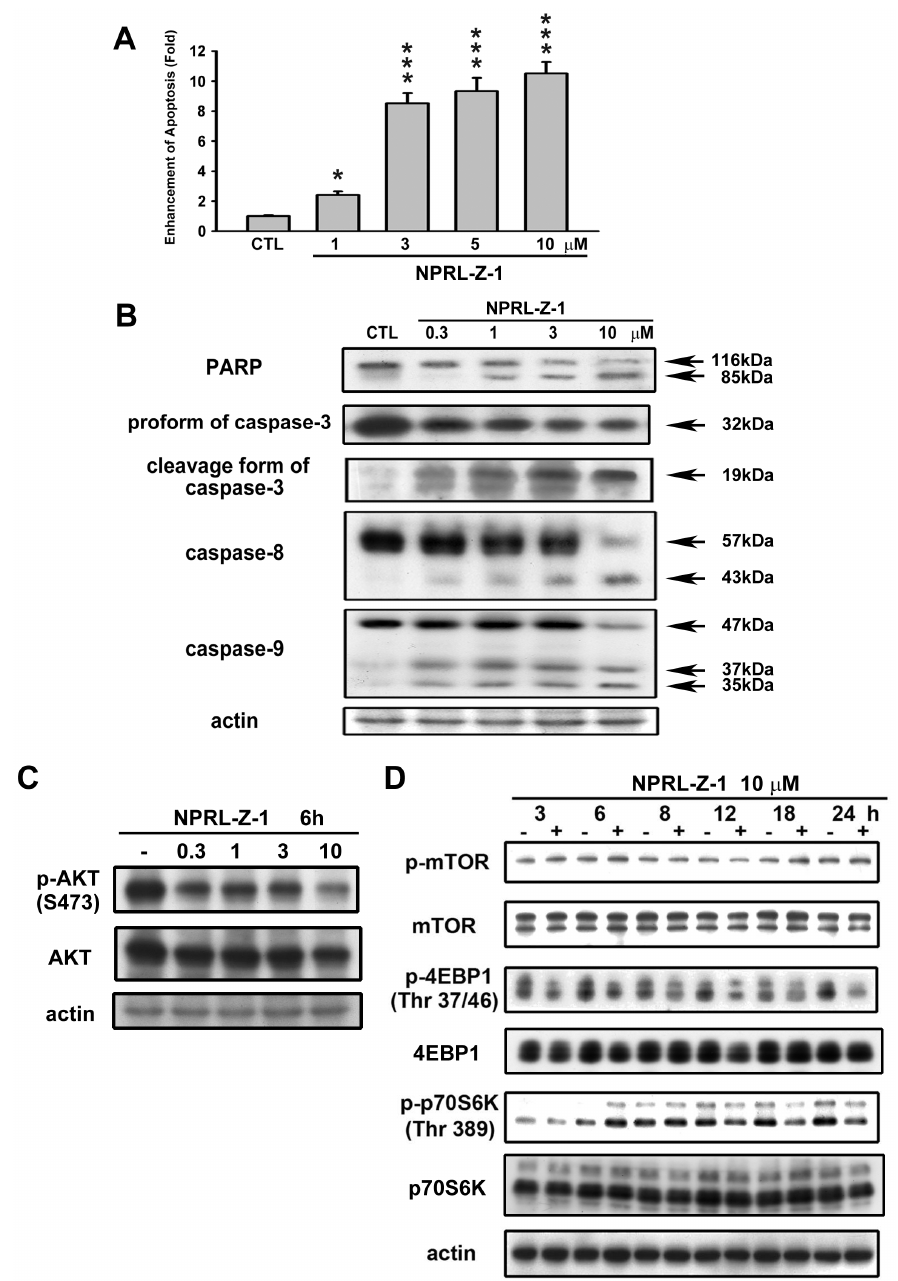
Figure 2. Effects of NPRL-Z-1 treatment on cell apoptosis induction and expression of apoptosis-related proteins in A498 cells. (A) Cells were treated with DMSO or NPRL-Z-1 at various concentrations (1, 3, 5, and 10 m M) for 24 h. Formation of cytoplasmic DNA was quantitatively measured by cell death ELISA PLUS kit. Data are expressed as the mean percentage of control 6 S.D. of three independent experiments. * P , 0.05, and *** P , 0.001 compared with the control group. A498 cells were incubated in the absence or presence of NPRL-Z-1 at various concentrations (0.3, 1, 3, and 10 m M) for 24 h (B) and 6 h (C), and cells were harvested and prepared for detection by Western blotting. (D) Cells were treated for indicated times, and the cell lysates were subjected to immunoblotting by using indicated antibodies. damage pathway. NPRL-Z-1 inhibited the ability of TOP2 to and TOP2 b -mediated cleavable complexes (Fig. 5B). However, NPRL-Z-1 had no effect on TOP1–DNA complexes in A498 cells convert supercoiled DNA to relaxed DNA as well as etoposide (Fig. 5A). Furthermore, the band depletion assay was performed to (Fig. 5C). The TOP1 poison camptothecin was used as a positive detect free intracellular topoisomerases that were not covalently control. Moreover, after replacement of medium containing bound to cellular DNA. NPRL-Z-1 or etoposide treatment of NPRL-Z-1 or etoposide with fresh growth medium, TOP2 a and TOP2 b expression was restored (Fig. 5D). These data clearly A498 cells caused depletion of TOP2 a and TOP2 b , suggesting that NPRL-Z-1 increased intracellular accumulation of TOP2 a -